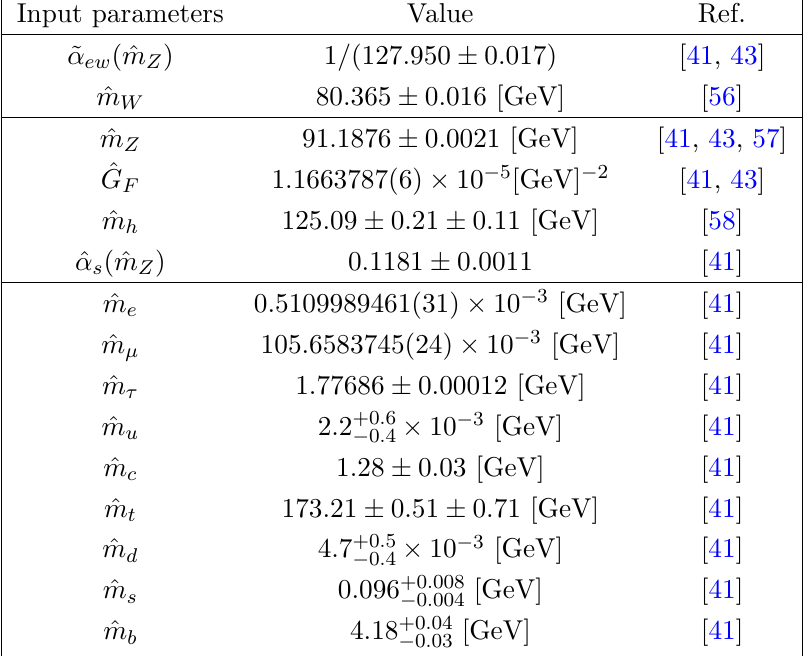
Table 2 . Set of parameters used as inputs and corresponding numerical values. Only one parameter between ~ (cid:11) ew ( ^ m Z ) and ^ m W is retained, depending on the input scheme chosen. Note that the value of the ^ m W is the Tevatron extracted value, not the global average that includes LEP extractions of ^ m W that are harder to interpret in the SMEFT